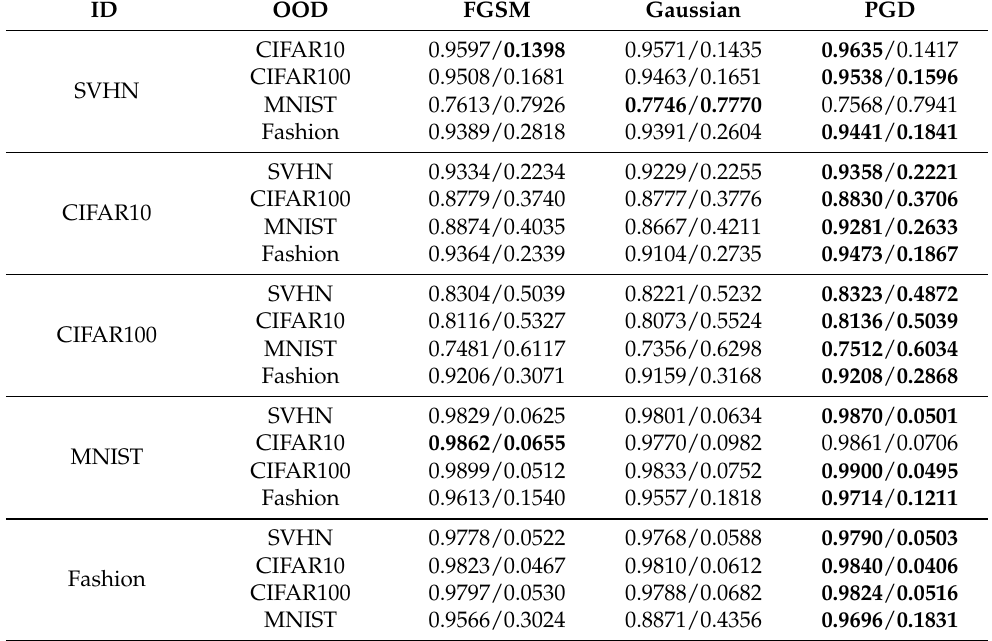
Table 5. Comparison of the OOD detection performance of AdvSCOD with different types of perturbation. The values on the left side and right side of “/” are the results measured by AUROC and FPR95, respectively. Bold numbers are superior results.